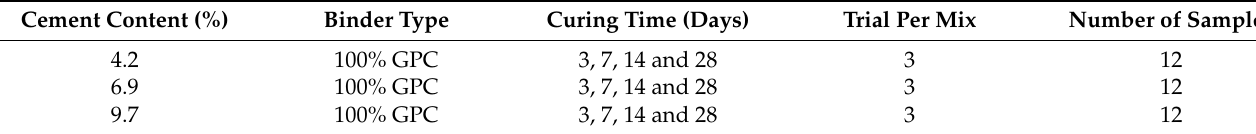
Table 2. Punching shear test configuration.